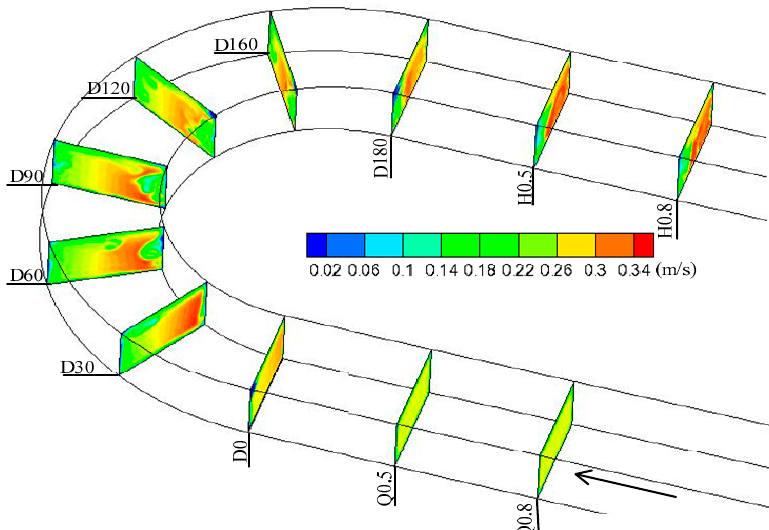
Figure 8. Velocity distribution along the cross section.